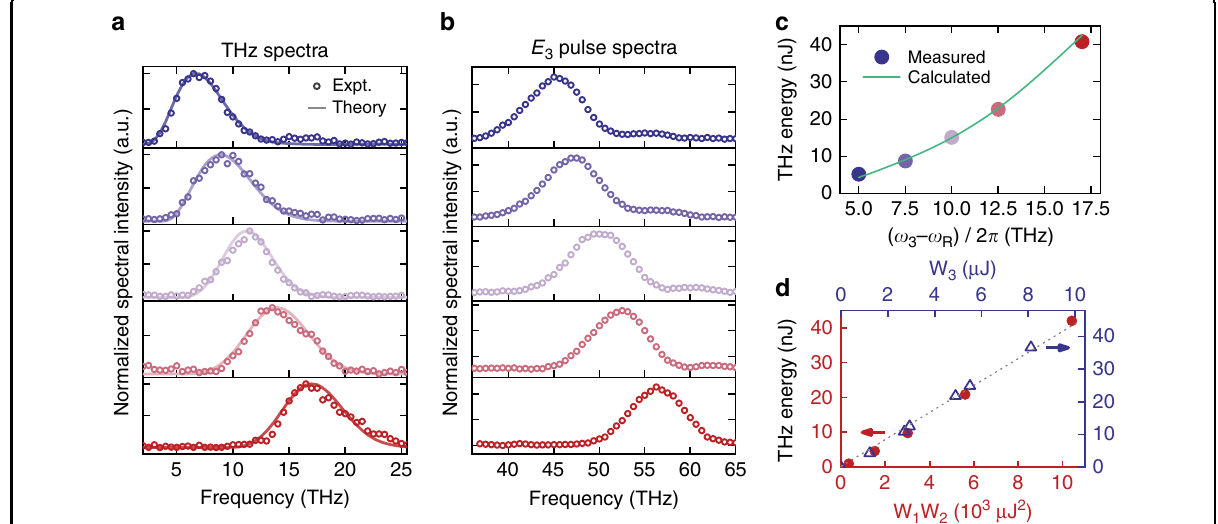
Fig. 2 Experimental results on R-FWM in diamond. a THz output spectra: top to bottom frames for beam geometry set to have the THz frequency PM at 5, 7.5, 10, 12.5, and 17 THz, respectively. Solid curves are theoretical fi ts. b Measured one-to-one corresponding spectra of the converting ~ E 3 pulses with respect to the THz spectra in ( a ). c Output THz energy per pulse (circles) for the fi ve beam geometries set in a and calculated THz energy (curve) using χ ð 3 Þ ¼ 2 : 8 ´ 10 (cid:3) 12 esu. d Data showing the linear dependences of THz pulse energy on energy product of ω 1 and ω 2 pulses and on energy of the ω 3